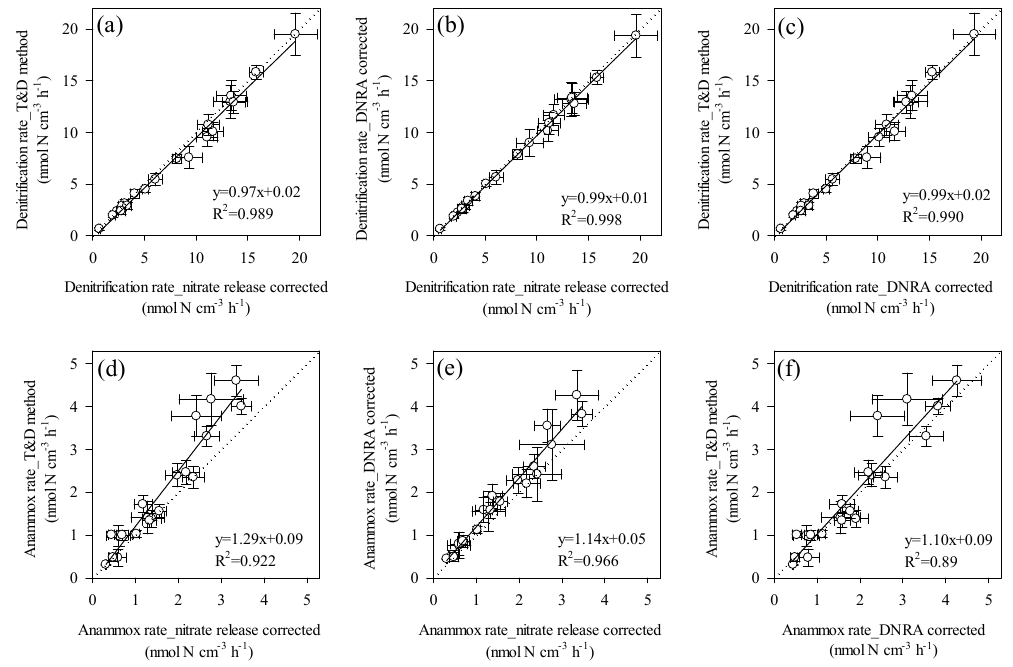
Fig. 7. The influence of nitrate release and DNRA on anammox and denitrification rates in the experiment amended with 15 NO − method: Thamdrup and Dalsgaard (2002). Nitrate release corrected: the rate calculation corrected by nitrate release. DNRA corrected: after nitrate release correction, the rate calculation was corrected by DNRA. See Sect. 2.4 Rate calculations for more detailed information. The dotted line represents the 1 : 1 line. The linear regression is shown for the interpretation of different processes effects on the anammox and denitrification rates.